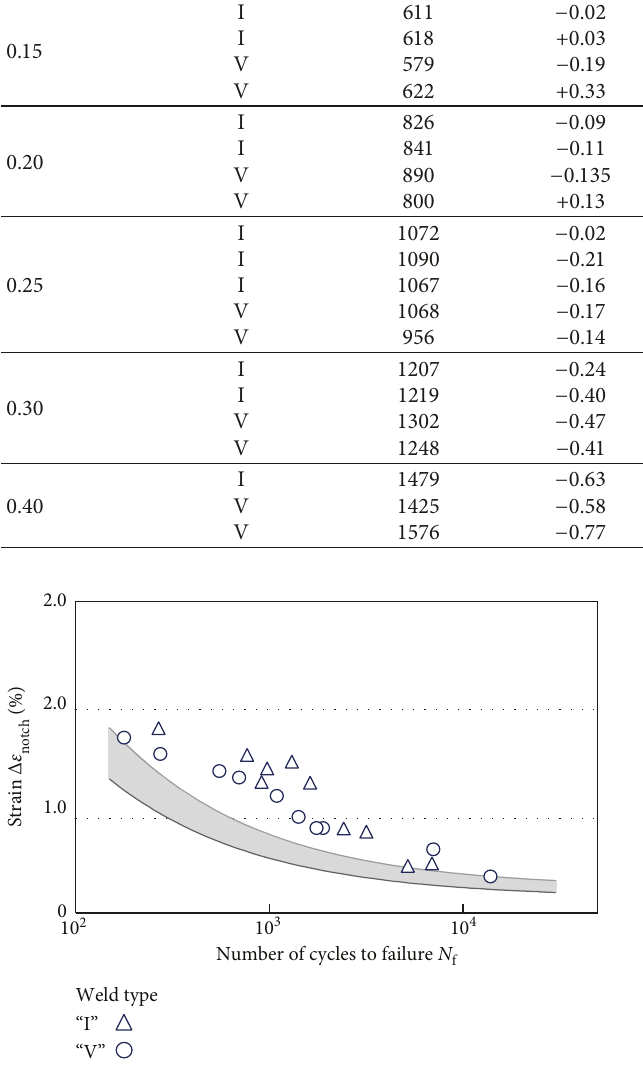
Figure 4: Comparison of the results obtained for the developed theoretical model of fatigue life prediction with experimental data. Grey area is the range of predicted fatigue life defined by equation (14) and obtained for different values of safety